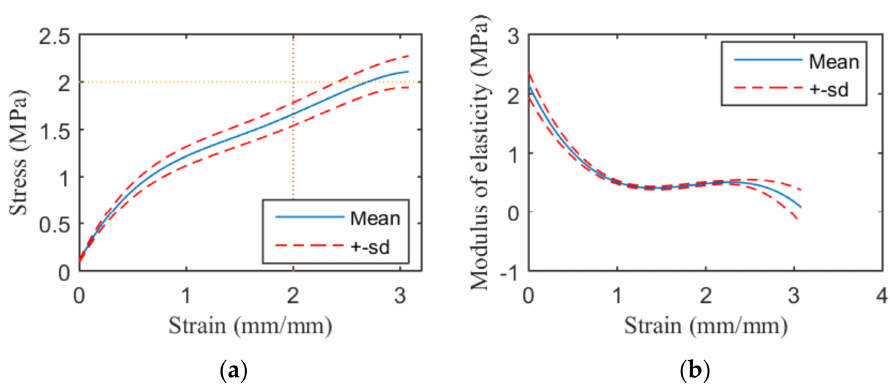
Figure 8. Stress-strain curve and modulus of elasticity of the Pattern C Dragonskin 30–TPU 95A specimens with a 1.4 mm pattern diameter: ( a ) stress-strain curve before yield and ( b ) modulus of